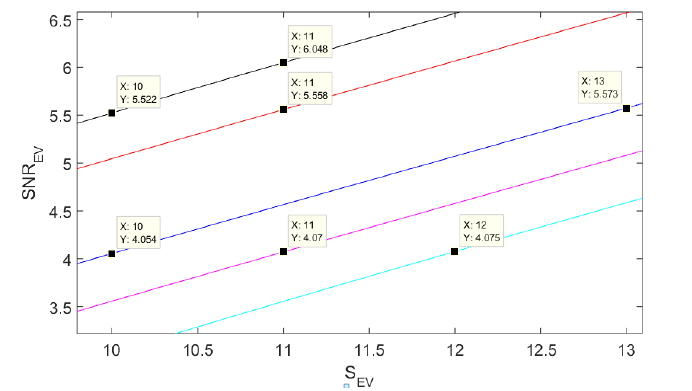
Figure 5. Detail of highlights in Figure